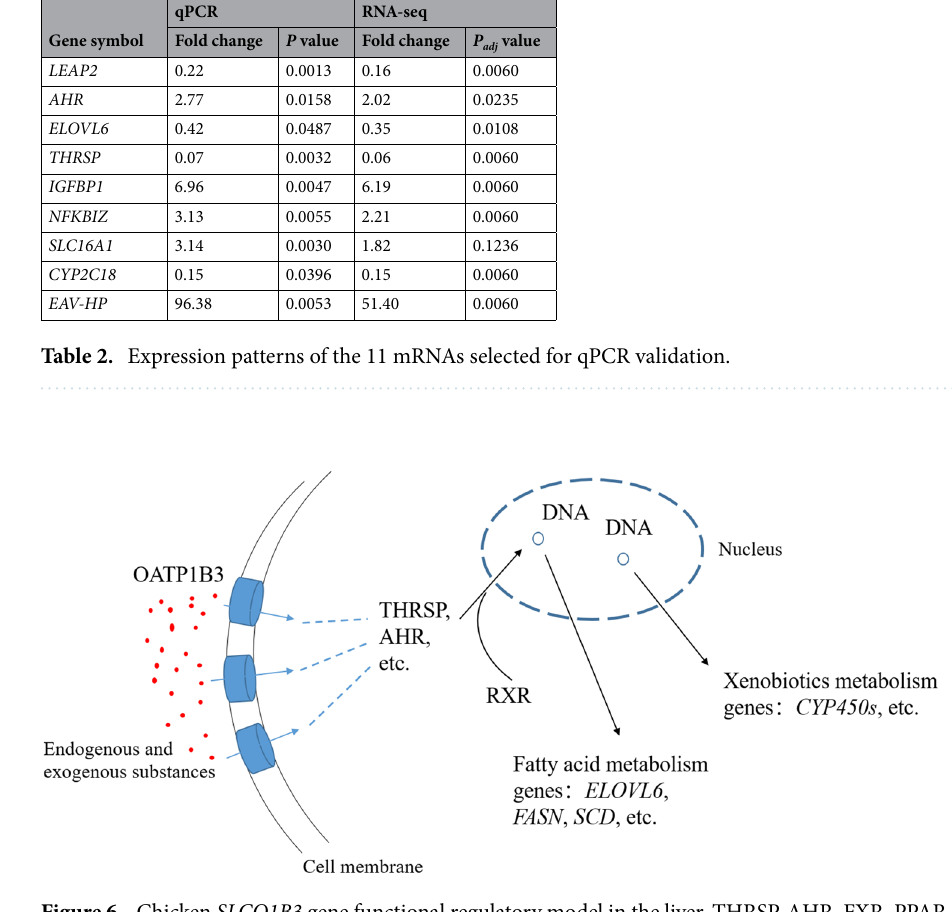
Figure 6. Chicken SLCO1B3 gene functional regulatory model in the liver. THRSP, AHR, FXR, PPAR represents transcription factors and RXR are their nuclear receptor, they can bind each other and form heterodimer. Many endogenous and exogenous substances are the ligands of the heterodimers descript above. We speculate that the OATP1B3 can regulate the cell fatty acid metabolism and xenobiotics metabolism via transporting various endogenous and exogenous